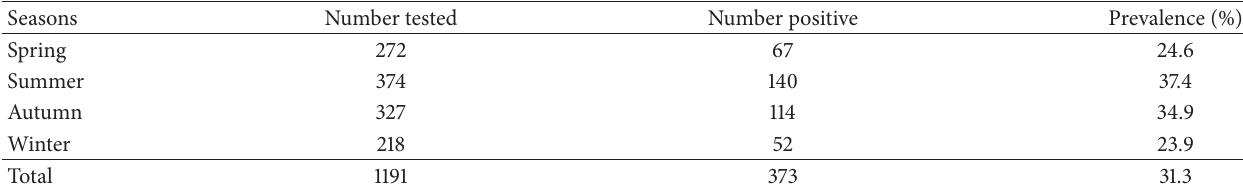
Table 2: Seasonal seroprevalence of Toxoplasma gondii infection in sows in Hunan Province,